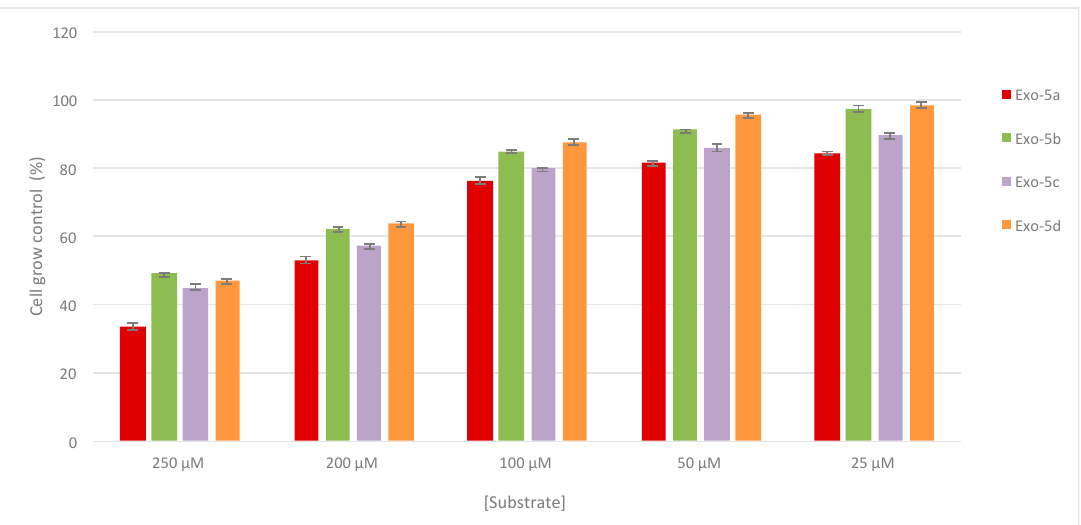
Figure 4. Antiproliferative effect of compounds exo -5a-d against A549 cells. The cellular-growth was measured by the SRB assay and reported as % relative to untreated control. Data are expressed as means ±SD of three independent observations ( p < 0.05).